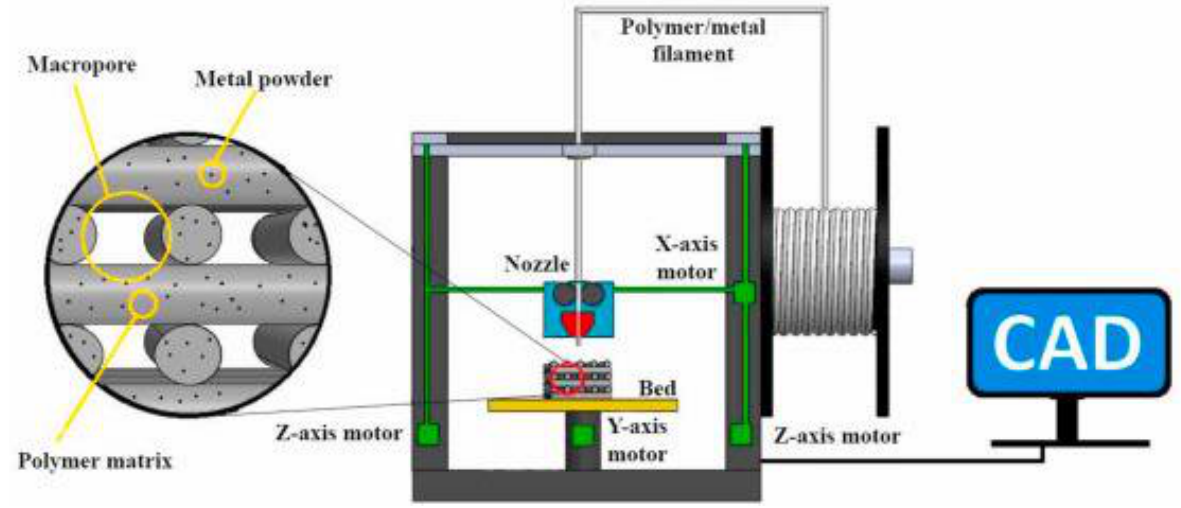
Figure 5. Schematic diagram of the FDM 3D printing process for polymer/metal scaffolds. Table 1. Polymer/Mg composite prepared by FDM 3D printing. Composite